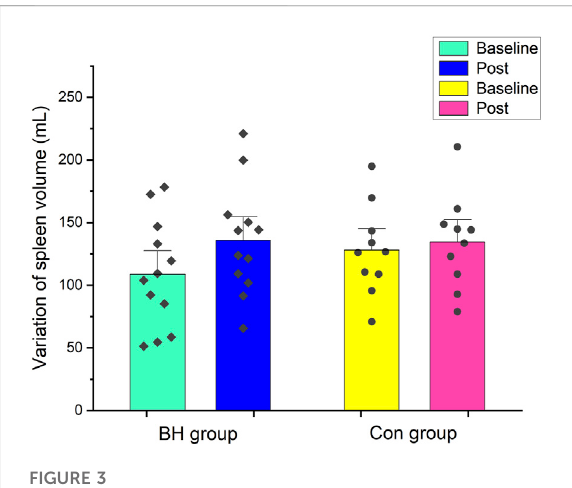
FIGURE 3 Mean (±SE) spleen volume (ml) variation from baseline to after 8 weeks in BH group and Con